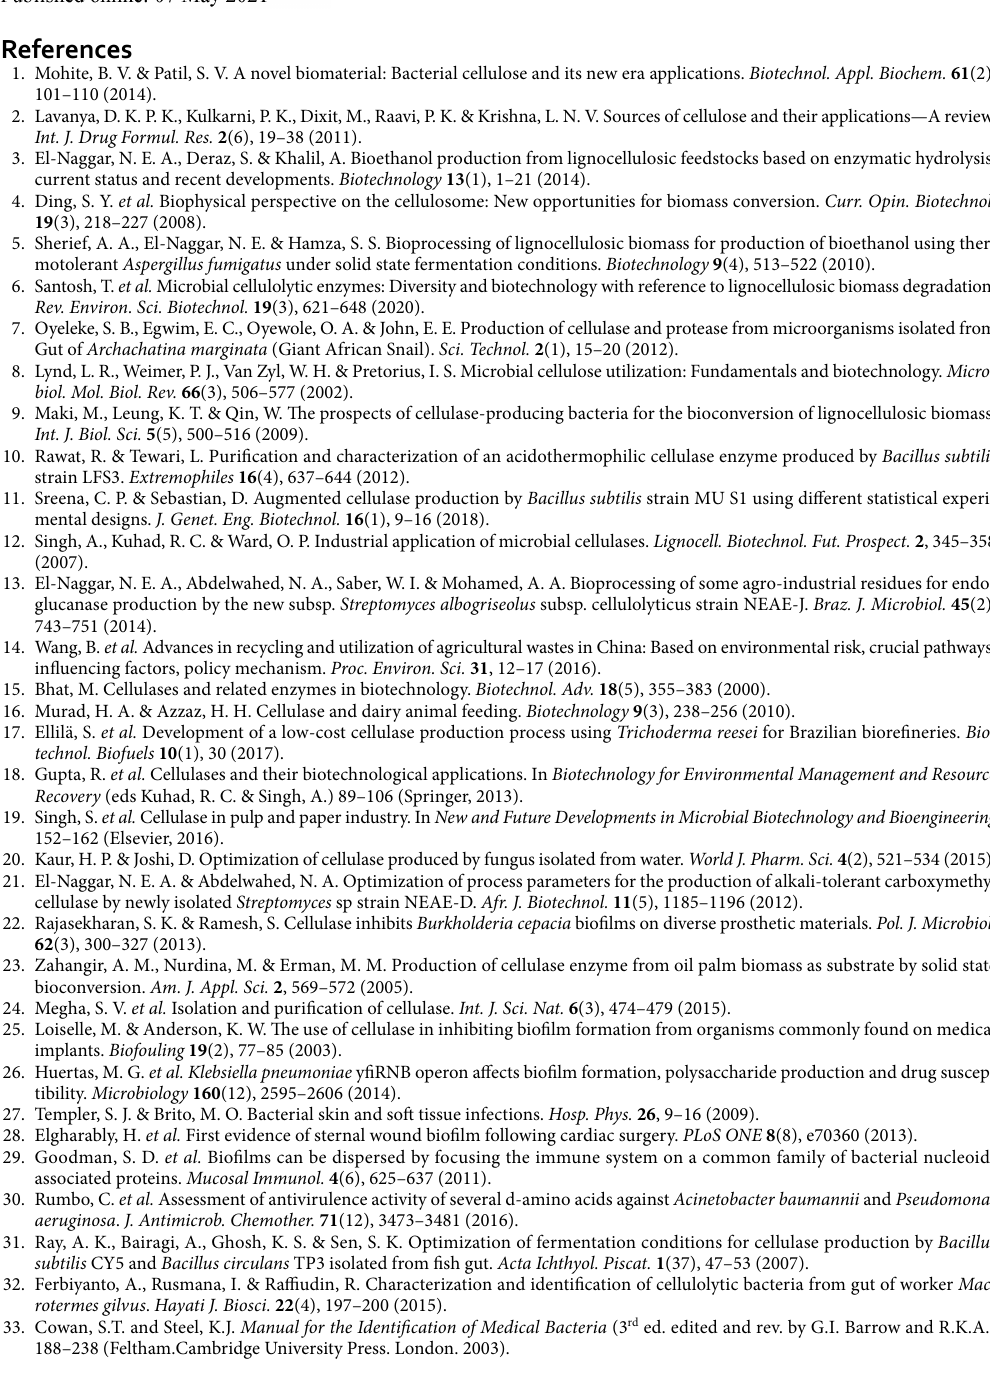
Table 10. Comparison of carbohydrate content of biofilm of different strains before and after enzyme treatment.